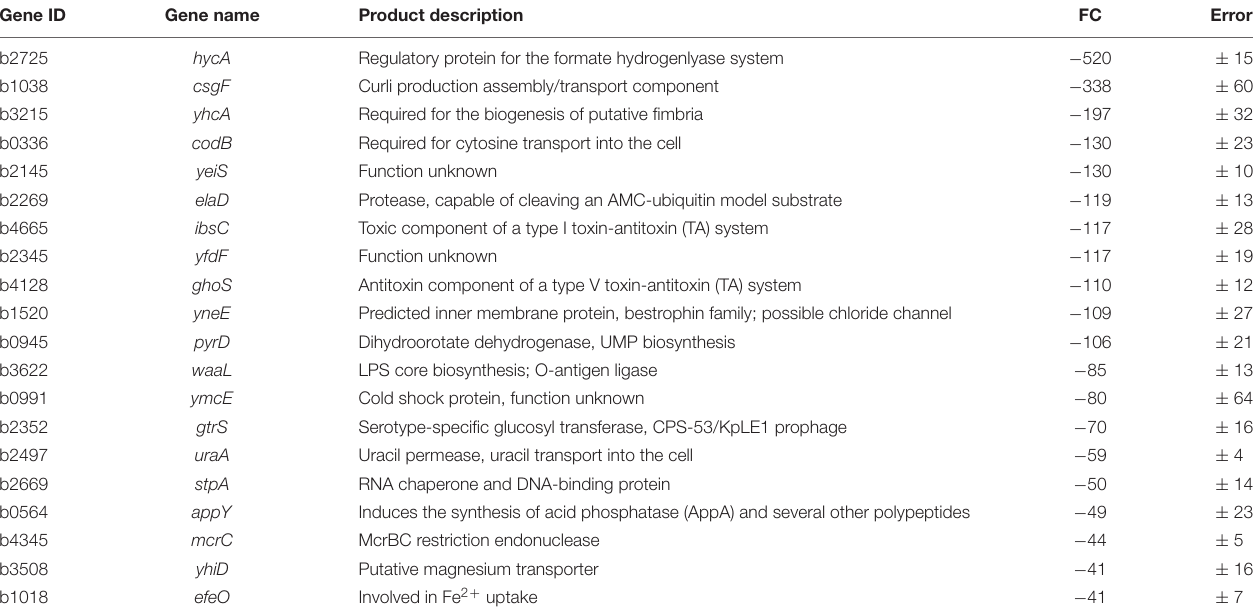
TABLE 3 | Top 20 most down-regulated genes after 10 min of exposure to 100 µ M